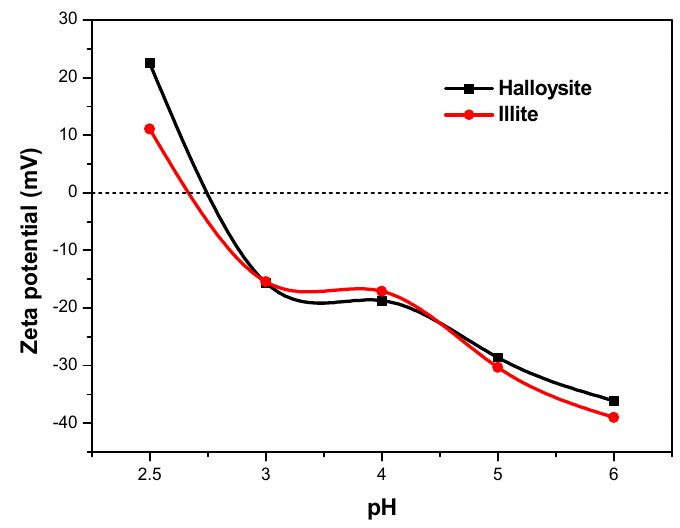
Figure 3. Zeta potential of halloysite and illite as a function of pH.